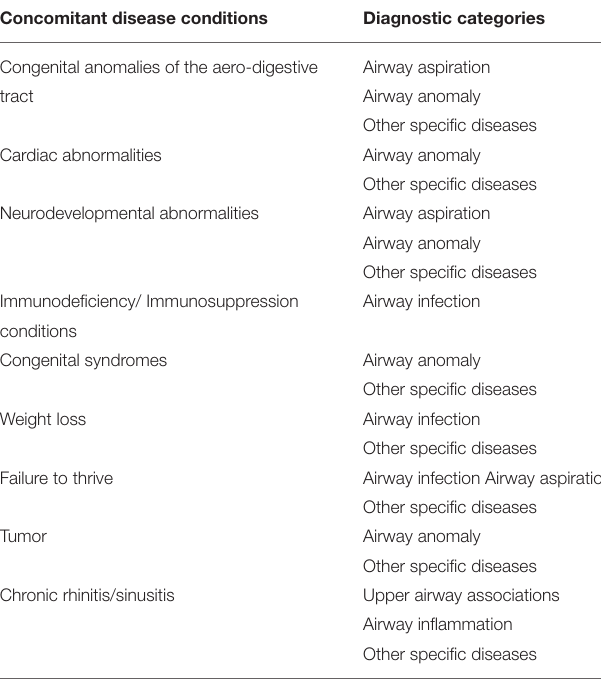
TABLE 11 | Associated symptoms and potential diagnostic category. TABLE 12 | Concomitant disease conditions and potential diagnostic